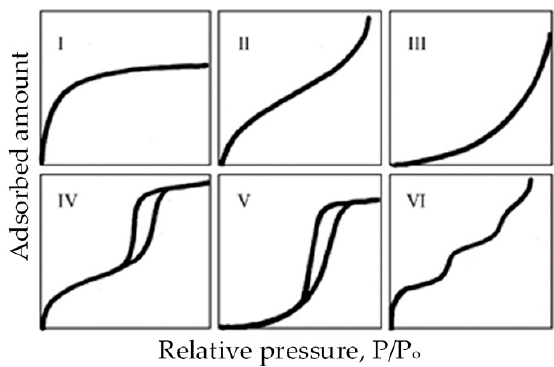
Figure 6. The International Union of Pure and Applied Chemistry (IUPAC) classification of adsorption isotherms [114].